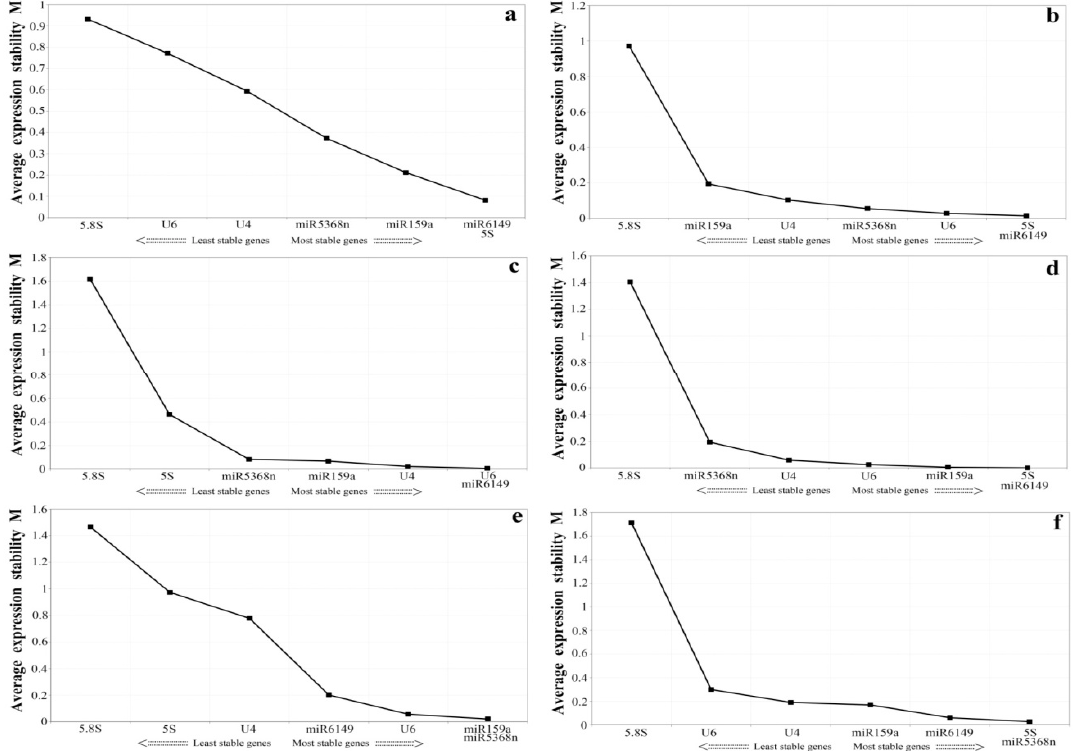
Figure 3. Average expression stability (M value) of seven candidate reference genes as calculated by geNorm. Expression stability was evaluated compared to untreated controls in ( a ) the bud to the second leaf; ( b ) E. oblique attack; ( c ) mechanical wounding; ( d ) SA; ( e ) MeJA; ( f ) ABA. A lower M value indicates more stable expression.